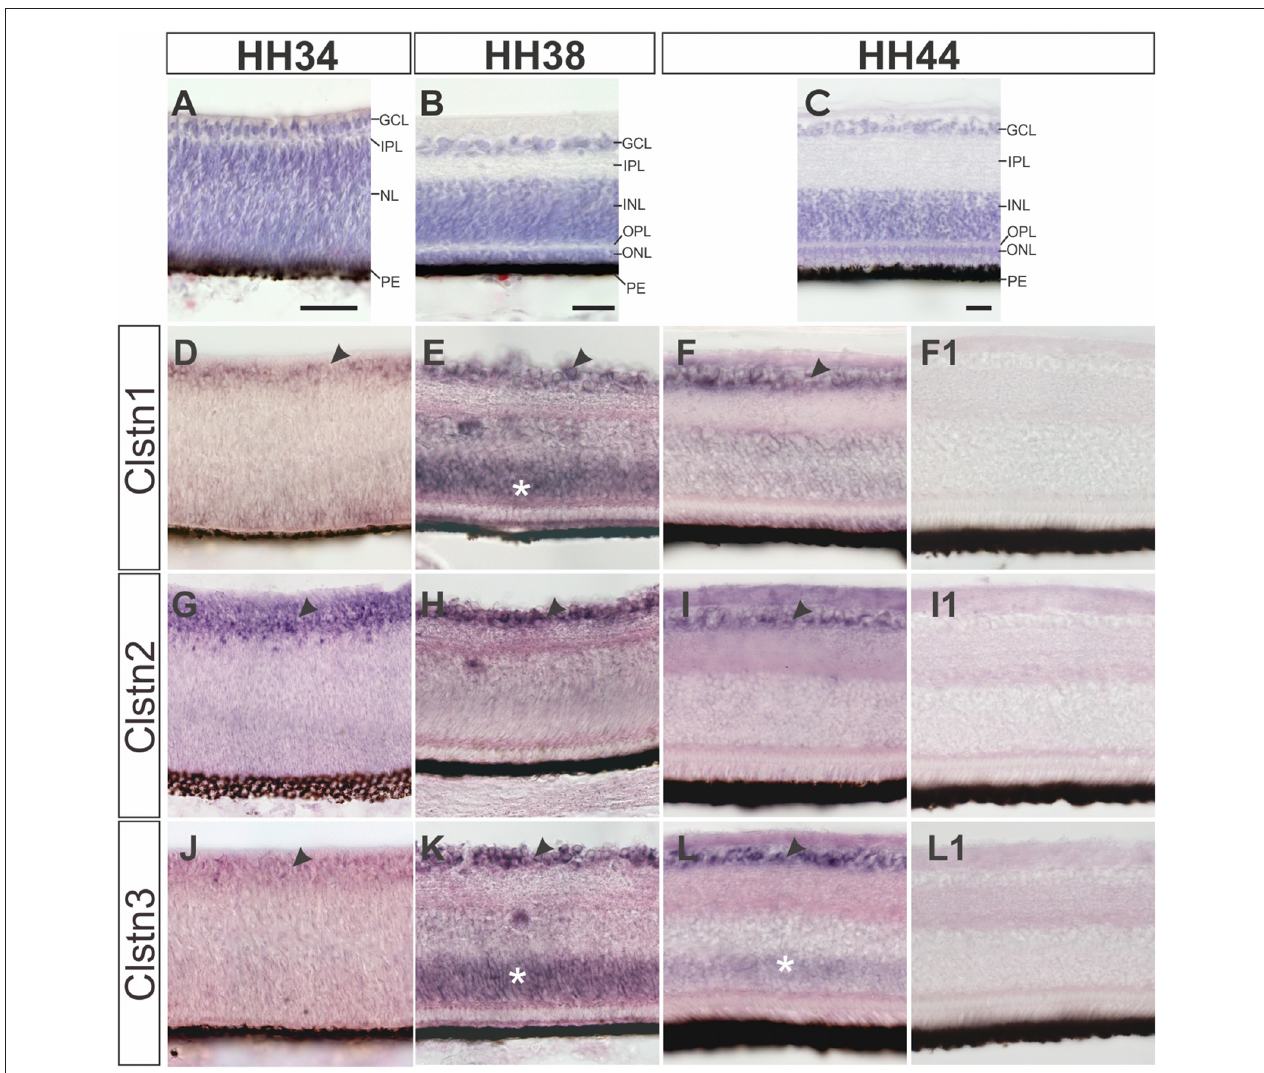
FIGURE 4 | Calsyntenins are expressed in the retina throughout development. The development of the retina is demonstrated by H&E staining at HH34 (A) , HH38 (B) and HH44 (C) . Clstn1 is expressed in retinal ganglion cells (RGCs) throughout development. By HH34 the expression in RGCs is weaker than at older stages (black arrowhead; D ). Transient expression was found in the outer part of the nuclear layer (white asterisk; HH38, E ). By HH44, expression levels are low in the inner nuclear layer (INL; but remain high in the RGCs (black arrowhead; F ). Clstn2 is expressed at high levels only in RGCs (black arrowhead, HH34, G ; HH38, H ; HH44, I ). Clstn3 expression was very similar to Clstn1. Low levels were found in the RGCs at HH34 (J) . At HH38 (black arrowhead, K ) and HH44 (L) , expression is high in RGCs. At HH38 (K) , Clstn3 mRNA was also found in the outer part of the INL (white asterisk). (F1,I1,L1) show sections adjacent to (F,I,L) processed with the respective sense probes. Bar: 50 µ